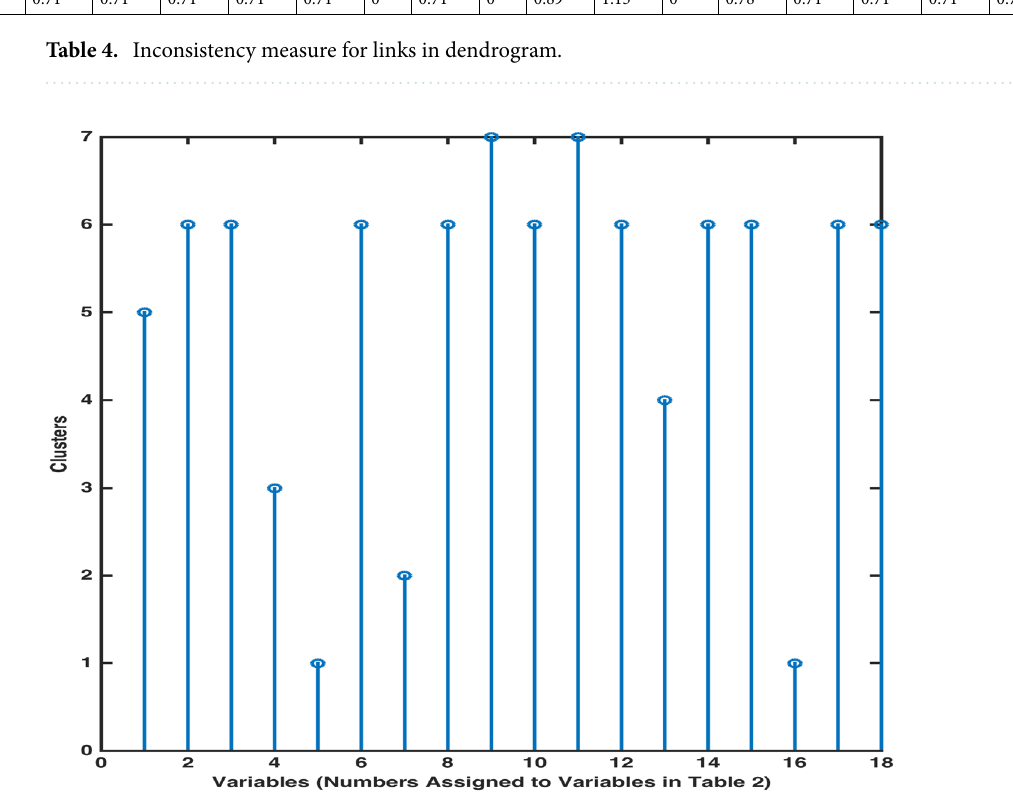
Figure 7. Stem diagram for clusters’